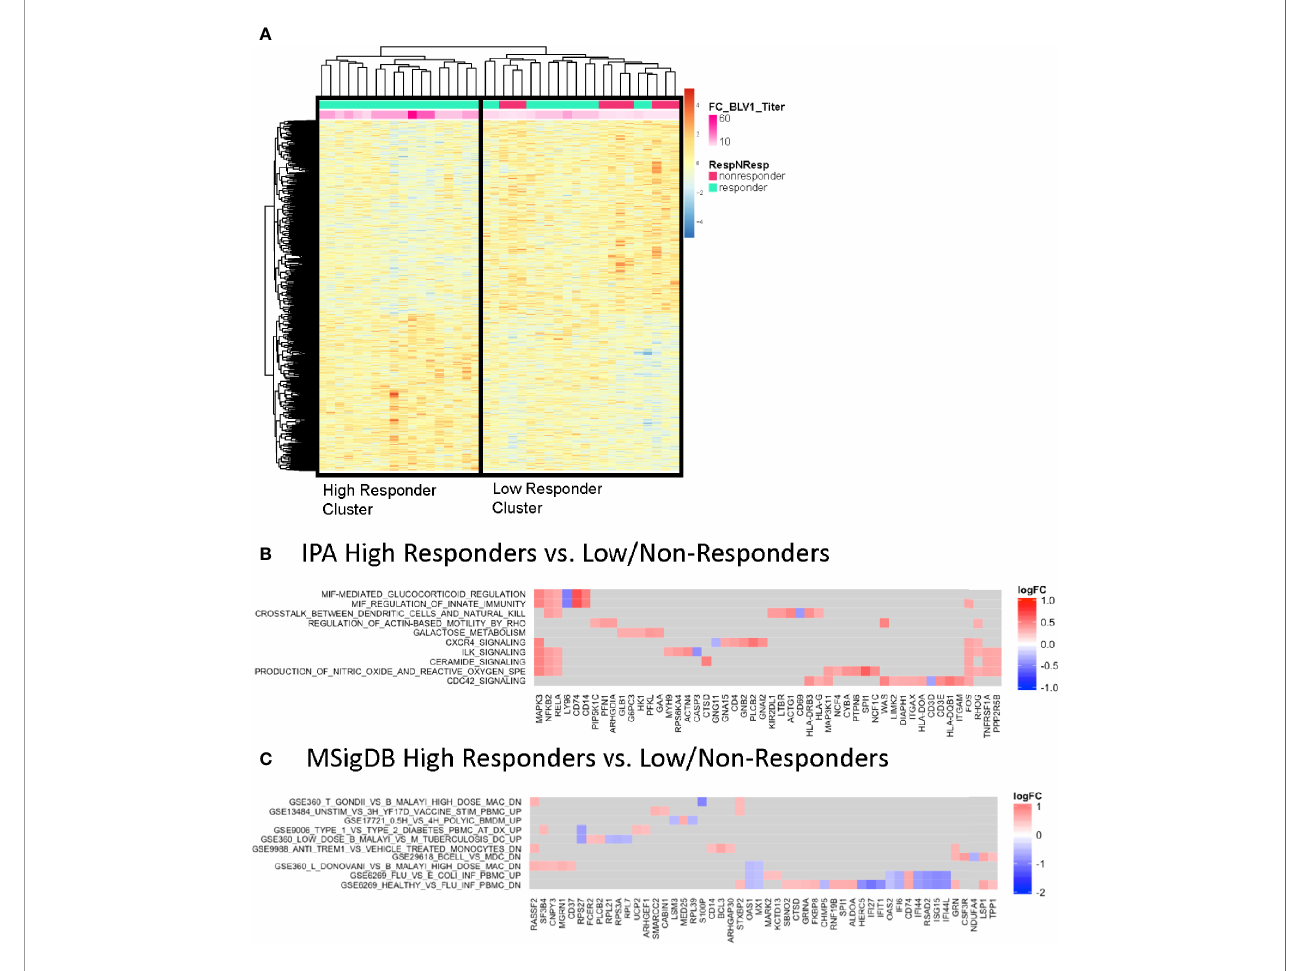
FIGURE 3 | Correlates of Vaccine-induced Antibody Responses Post-Vaccination. (A) Heatmap representation of the top signi fi cantly correlated transcripts from regressing baseline expression from all participants and fold change difference in pH1N1 antibody titers at V1 compared to BL. The expression intensities are represented using a blue-white-red color scale. Rows correspond to probes and columns correspond to pro fi led samples (p ≤ 0.05). “ High ” responder and “ low/ non ” responder clusters were compared and subjected to gene set enrichment analysis using the IPA database (B) and MSigDB Immunologic signature model (C)